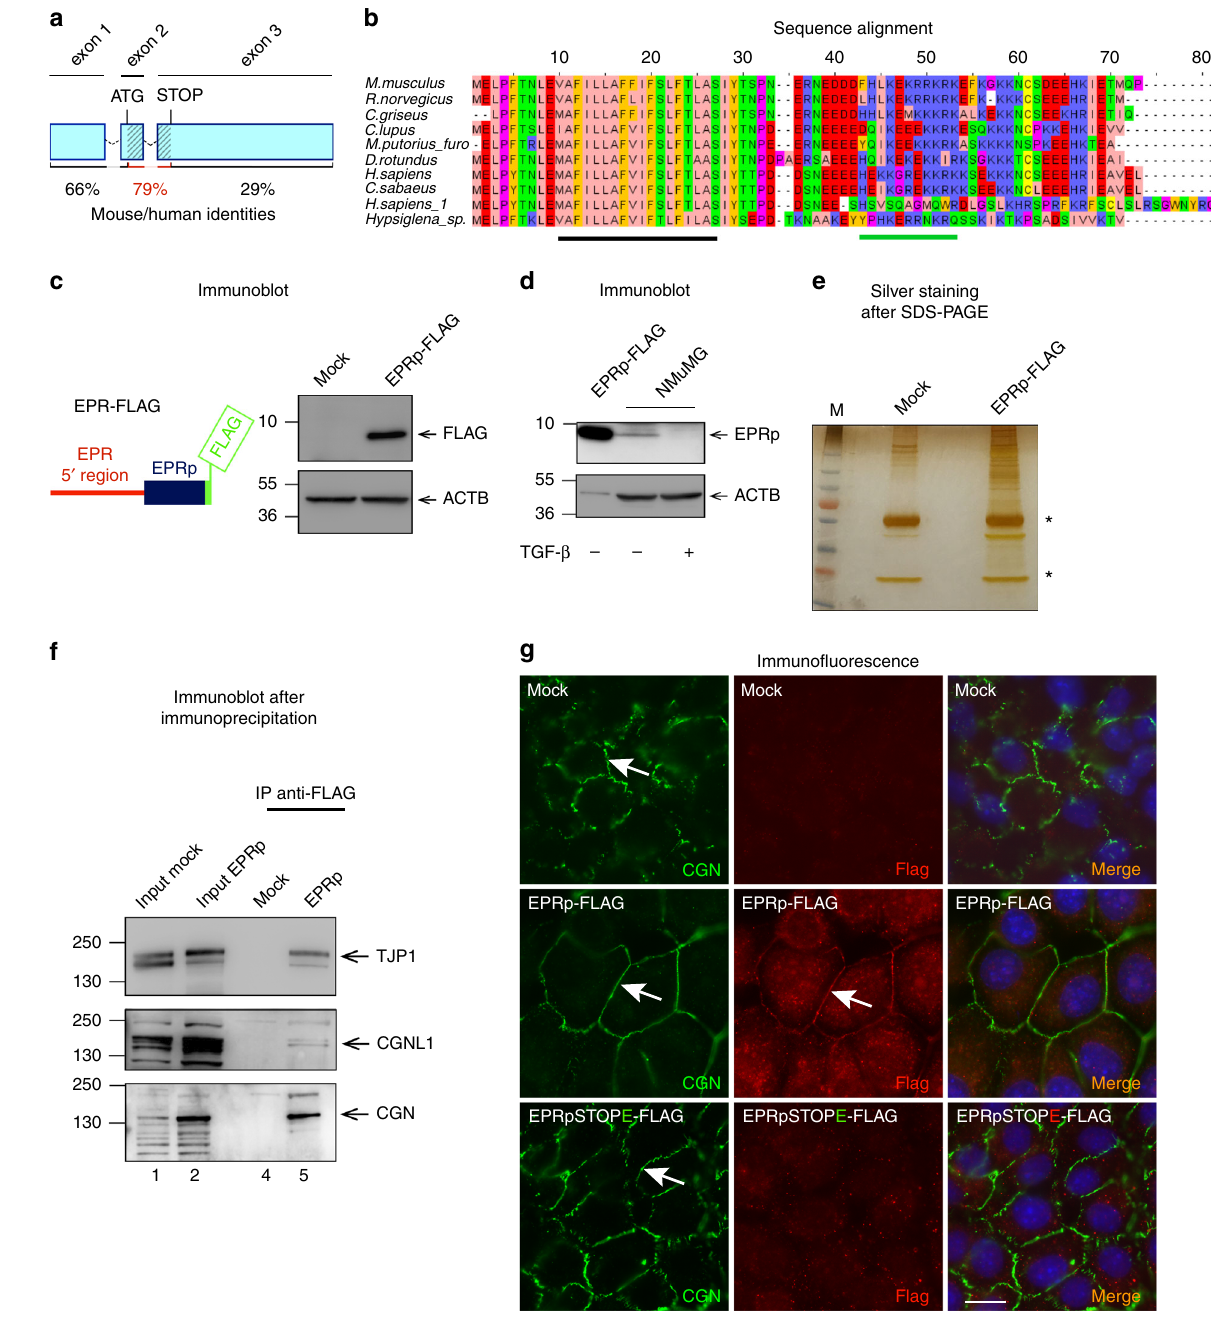
Fig. 2 A small peptide (EPRp) originates from EPR and displays junctional localization. a Schematic of the exon − intron structure (not in scale) of EPR, a putative ORF is dashed. Percentage of human/mouse identity in the putative ORF and in its fl anking RNA regions is presented. b Alignment of the predicted mammalian amino acids sequence encoded by the putative ORF present in EPR and in its orthologs. The position of the predicted transmembrane α -helix is shown as a solid black bar while the position of an additional cytoplasmic α -helix is shown as a solid green bar. c Left, diagram of the FLAG-fusion construct used for transfection (EPRp-FLAG); right, immunoblot analysis of total cell extracts from either mock or EPRp-FLAG-transfected HEK-293 cells. d Immunoblot analysis of total cell extracts from NMuMG cells serum-starved and either treated with TGF- β ( + ) for 24 h or untreated ( − ); extracts from EPRp-FLAG-transfected HEK-293 cells (EPRp-FLAG) represent a positive control. e SDS-PAGE analysis of total cell extracts from either mock or EPRp- FLAG-overexpressing (EPRp-FLAG) NMuMG cells immuno-puri fi ed using anti-FLAG monoclonal antibody. A representative silver-stained gel is shown. Asterisks indicate the position of immunoglobulin heavy and light chains. f Coimmunoprecipitation of FLAG-tagged EPRp and distinct junctional proteins (as indicated) in total extracts from NMuMG cells stably transfected with EPRp-FLAG. g Immuno fl uorescence analysis of either mock or EPRp-FLAG- or EPRpSTOPE-FLAG-stably transfected NMuMG cells cultured to con fl uence, to allow formation of cell − cell junctions. Arrows point to CGN and EPRp-FLAG junctional localization. Scale bar: 10 μ m. For immunoblots, the indicated antibodies were used; the position of molecular mass markers is presented on the left and representative gels are shown. ACTB is also known as Actin